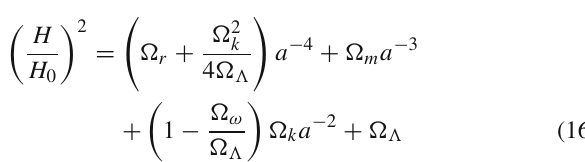
Table1 Constraintsat1 σ ( 68% ) CLerrorsonthecosmologicalparam- eters for our two cosmology models A , B , based on Hoˇrava gravity, and the standard cosmology models, spatially-flat ( k = 0 ) LCDM and spatially-non-flat ( k (cid:6)= 0) kLCDM, based on GR. In the bottom lines, Model Parameters Model A Model B kLCDM LCDM